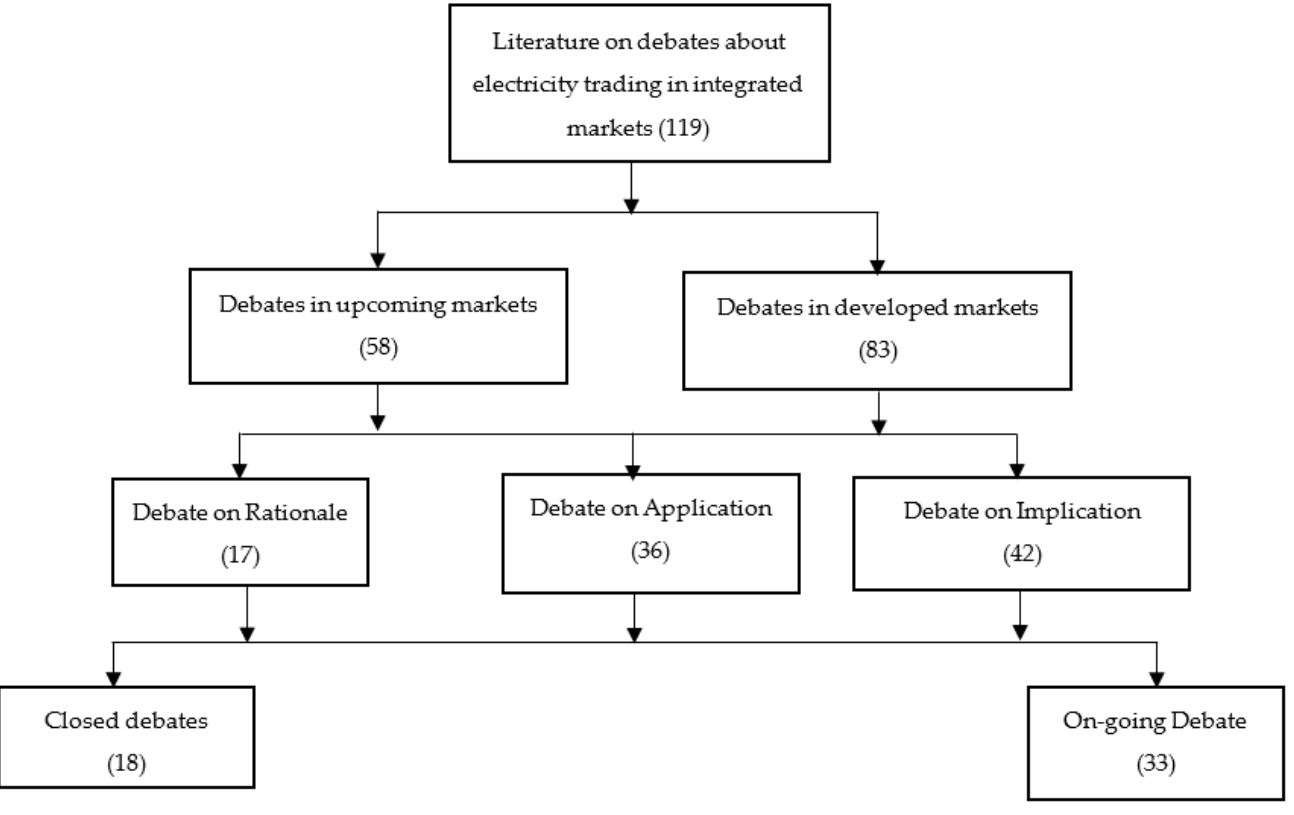
Figure 1. Review strategy on debates and paradigms.